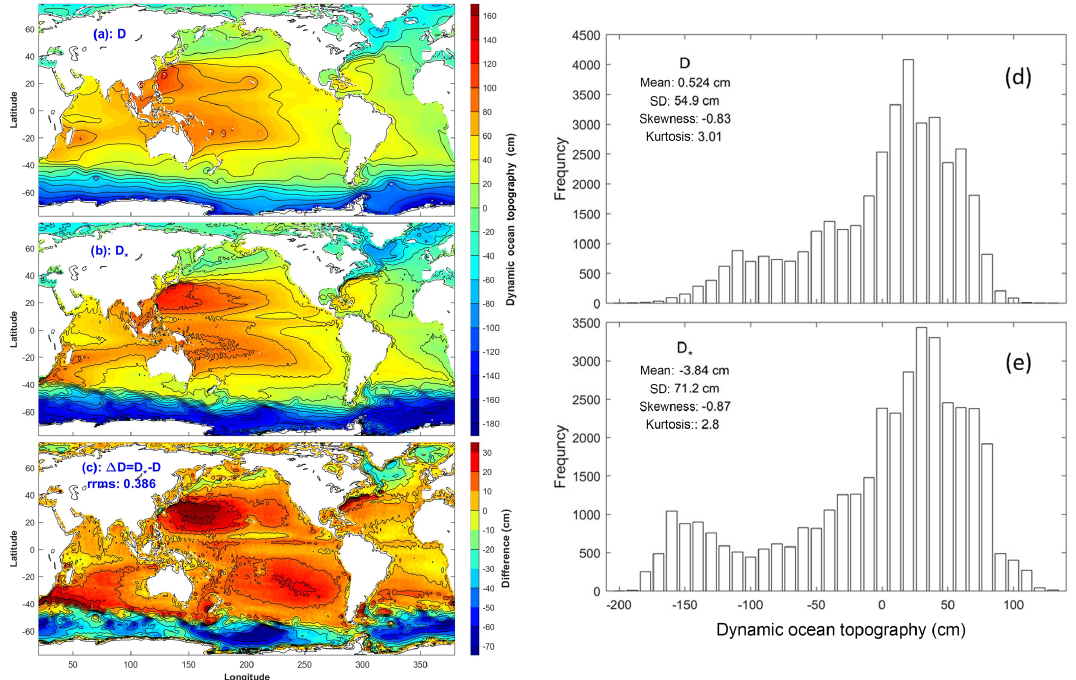
Figure 2. (a) First type of DOT (i.e., D ) which is the solution of Eq. (32) with boundary condition of Eq. (37, unit: cm), (b) sec- ond type of MDOT (1993–2006, i.e., D ∗ , unit: cm) downloaded from the NASA/JPL website: https://grace.jpl.nasa.gov/data/get-data/ dynamic-ocean-typography (31 July 2018), (c) difference between the two DOTs (i.e., (cid:49)D ), (d) histogram of global D , and (e) histogram of global D ∗ .